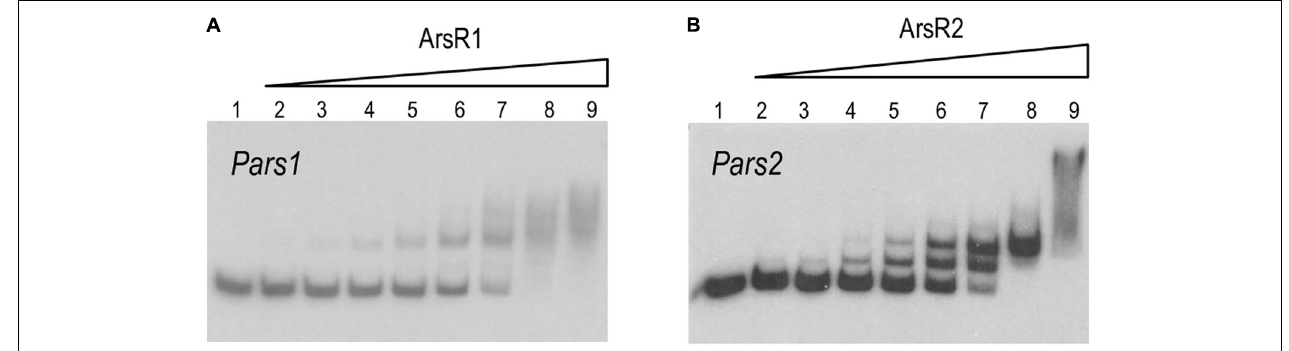
FIGURE 4 | (A,B) In vitro binding of 6His-ArsR1 and 6His-ArsR2 proteins to the Pars promoters. Gel retardation analyses were performed as indicated in section “Materials and Methods.” In both gels, lane 1 shows the free Pars1 or Pars2 probes, respectively; lanes 2 to 9 show retardation assay of Pars1 containing 5, 10, 25, 50, 100, 200, 500, and 1,000 nM of purified 6His-ArsR1 protein and retardation assay of Pars2 containing 10, 25, 50, 100, 200, 500, 1,000, and 2,000 nM of purified 6His-ArsR2